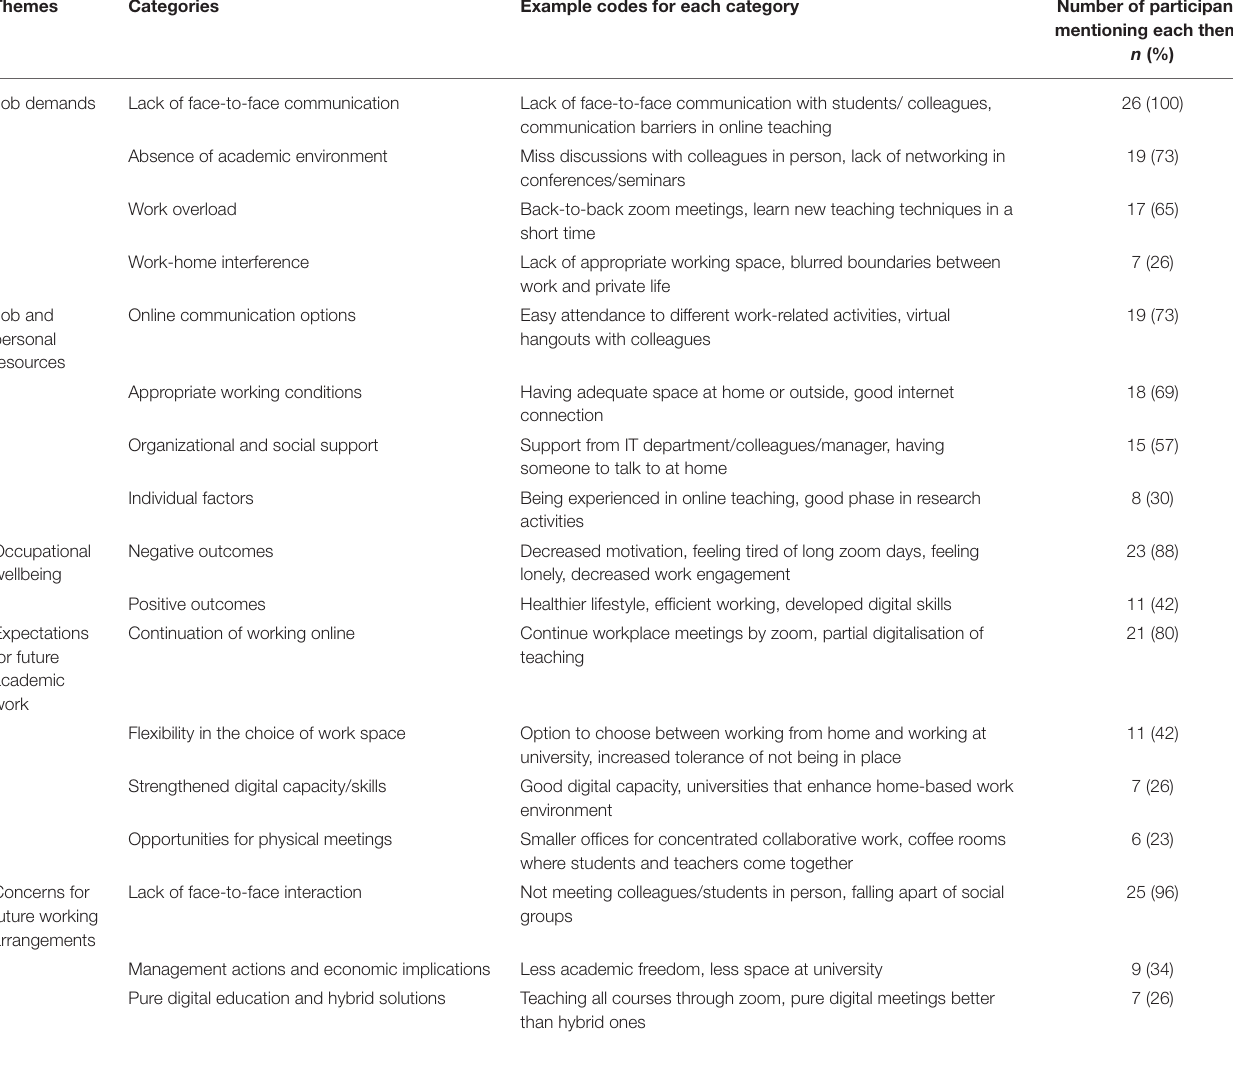
TABLE 2 | Themes categories and example codes, including the number of participants mentioning each